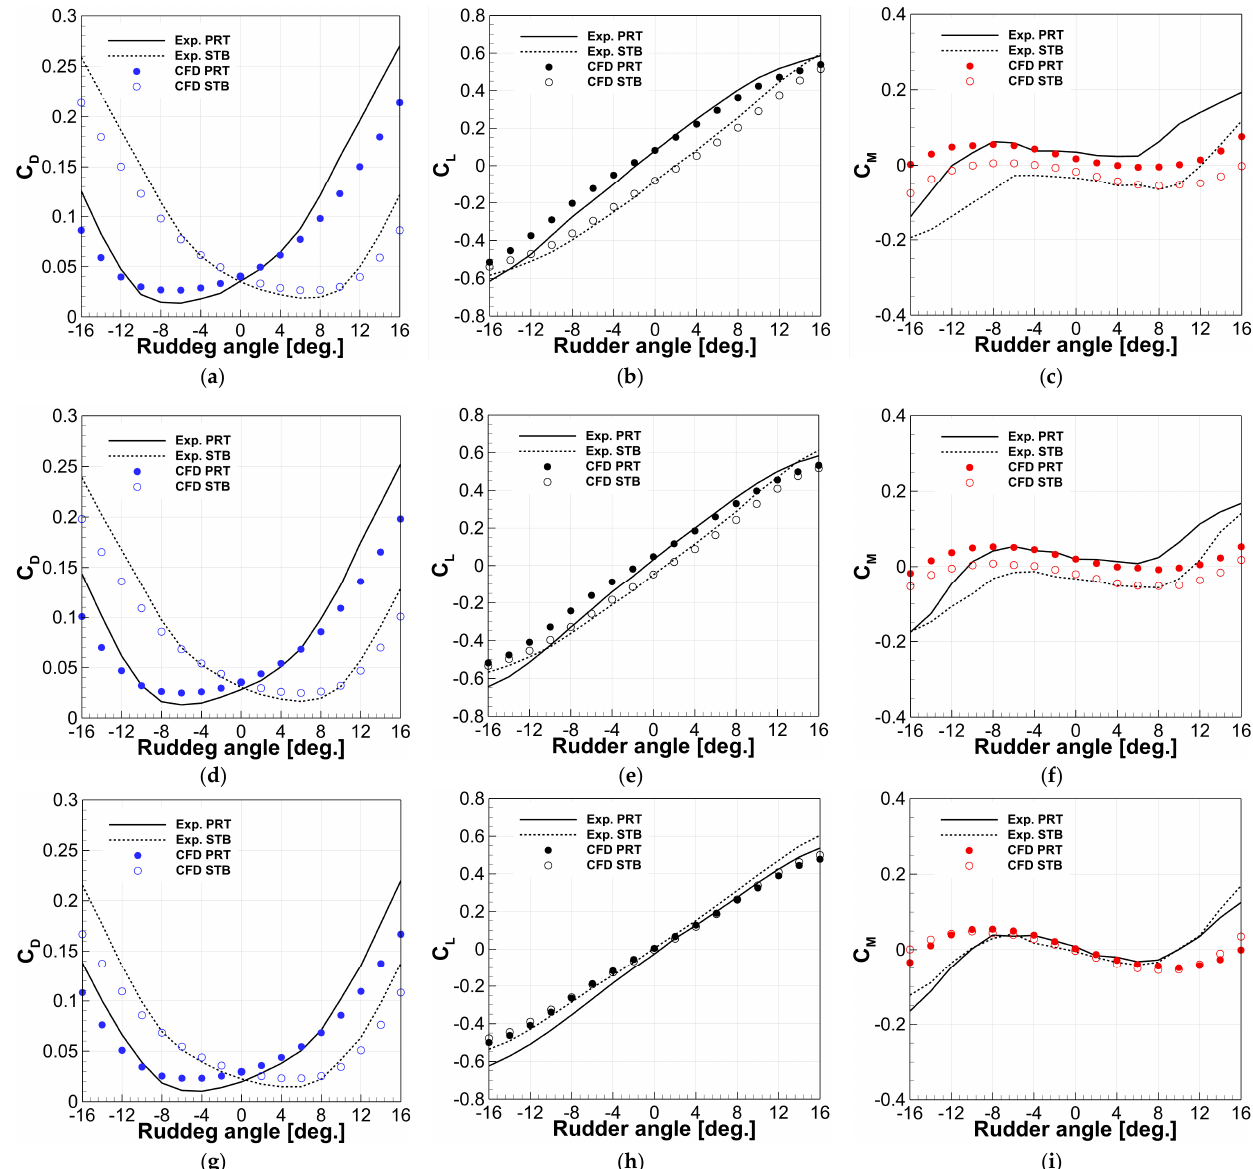
Figure 19. Measured and numerically predicted rudder forces and moment for the twisted rudders on the starboard and port side: ( a ) drag force for TR-ini; ( b ) lift force for TR-ini; ( c ) moment for TR-ini; ( d ) drag force for TR-int; ( e ) lift force for TR-int; ( f ) moment for TR-int; ( g ) drag force for TR-fin; ( h ) lift force for TR-fin; ( i ) moment for TR-fin.